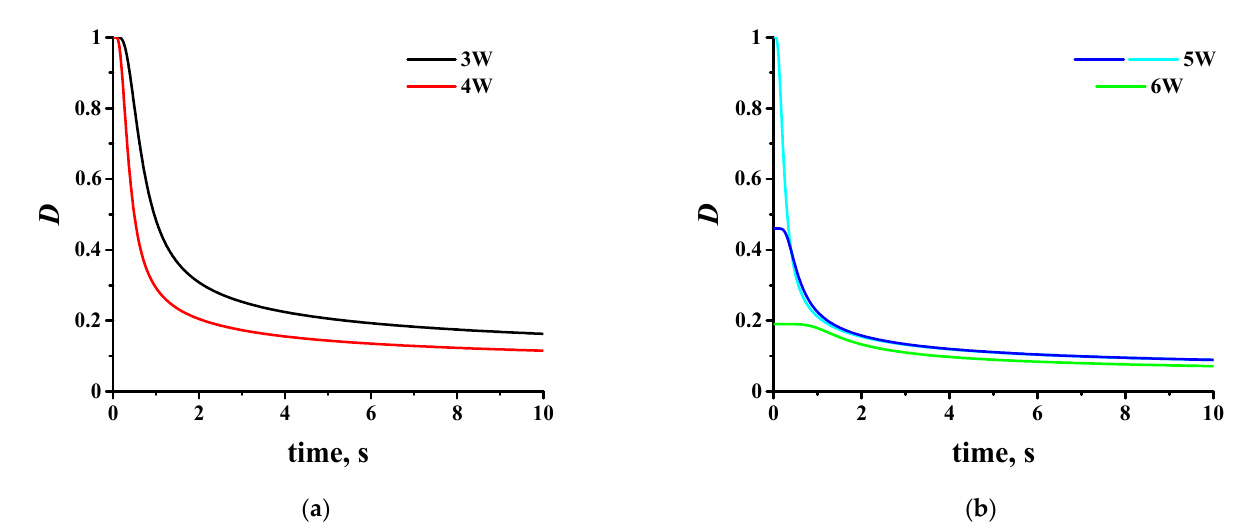
Figure 4 . Time dependence of the optical thickness of SAC calculated using the model for different laser powers P : ( a ) 3 W (black) and 4 W (red); ( b ) 5 W (blue and cyan) and 6 W (green).